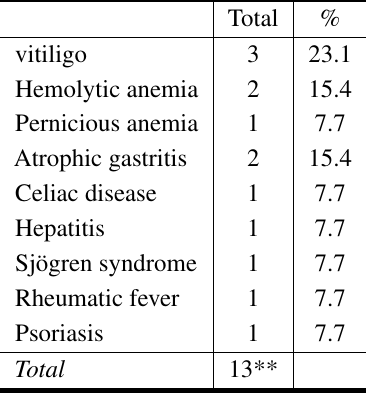
Most common autoimmune diseases in a cohort of Brazilian patients with